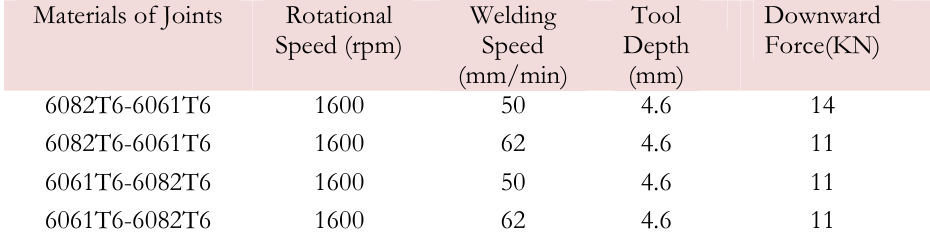
Table 3: Welding conditions employed to join the AA6082–AA6061